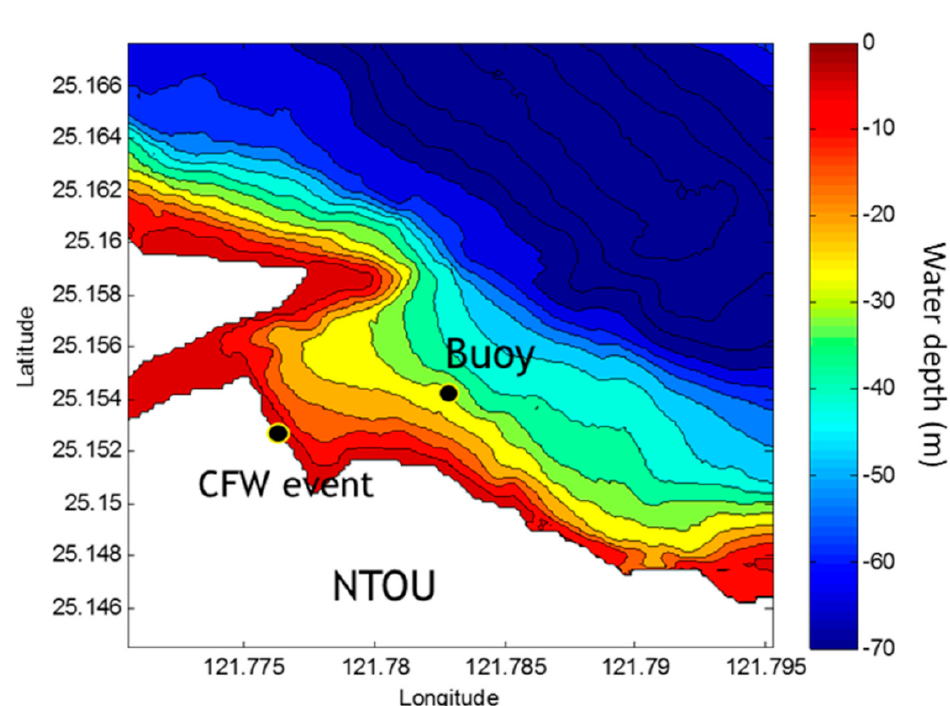
Figure 3. Bathymetry of the CFW occurrence sea area and the wave buoy